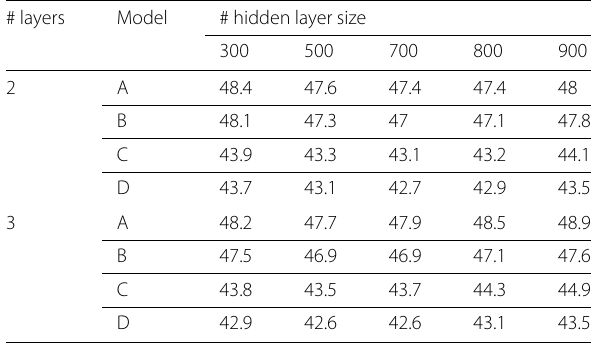
Table 11 LW-BGRU and LW-BrGRU accuracy as a function of the number of layer and hidden layer